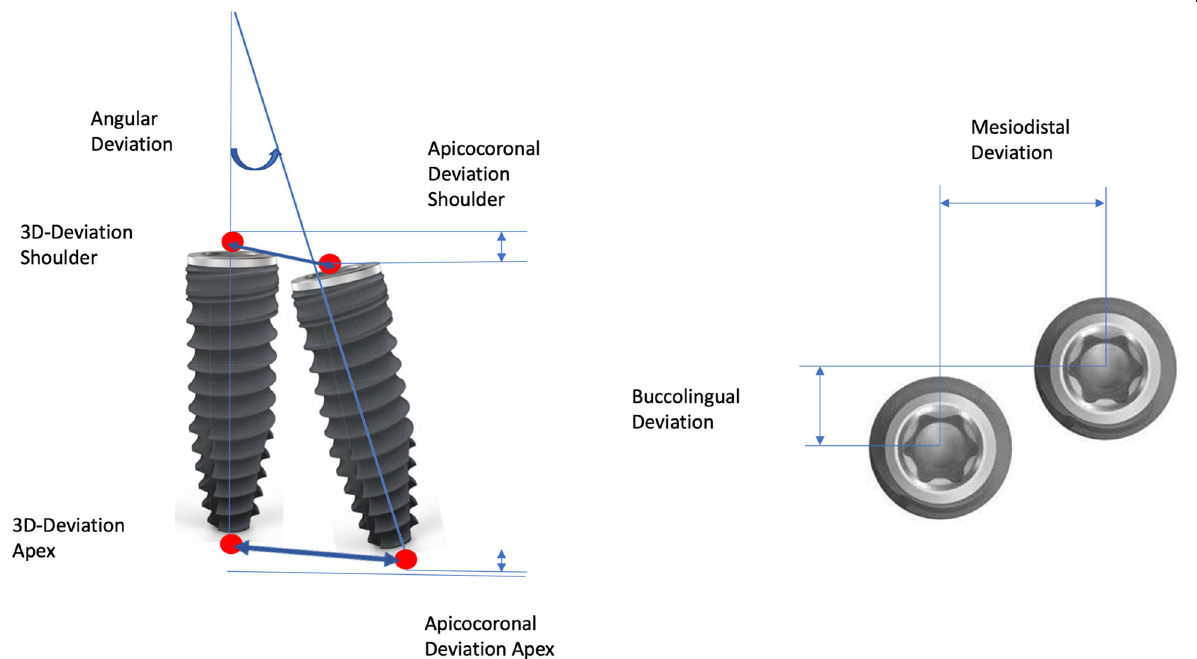
Fig. 1 Representation of the measuring distances and the angular deviation between the planned and actually achieved implant